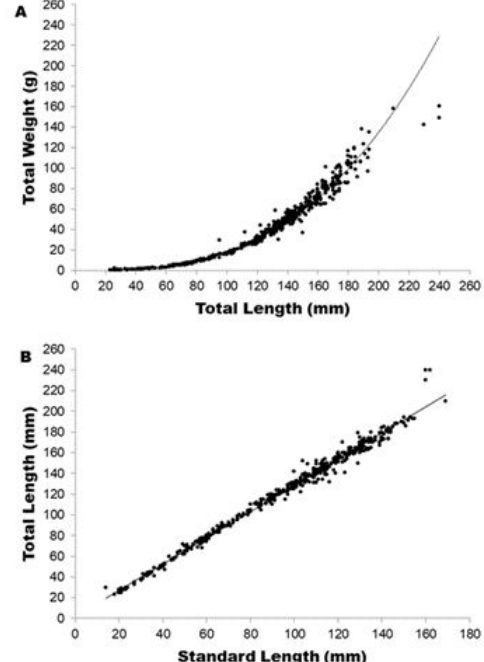
Figure 3. Total weight-total length relationship (A) and total length-standard length relationship (B) for P. managuensis at the Saco I dam,